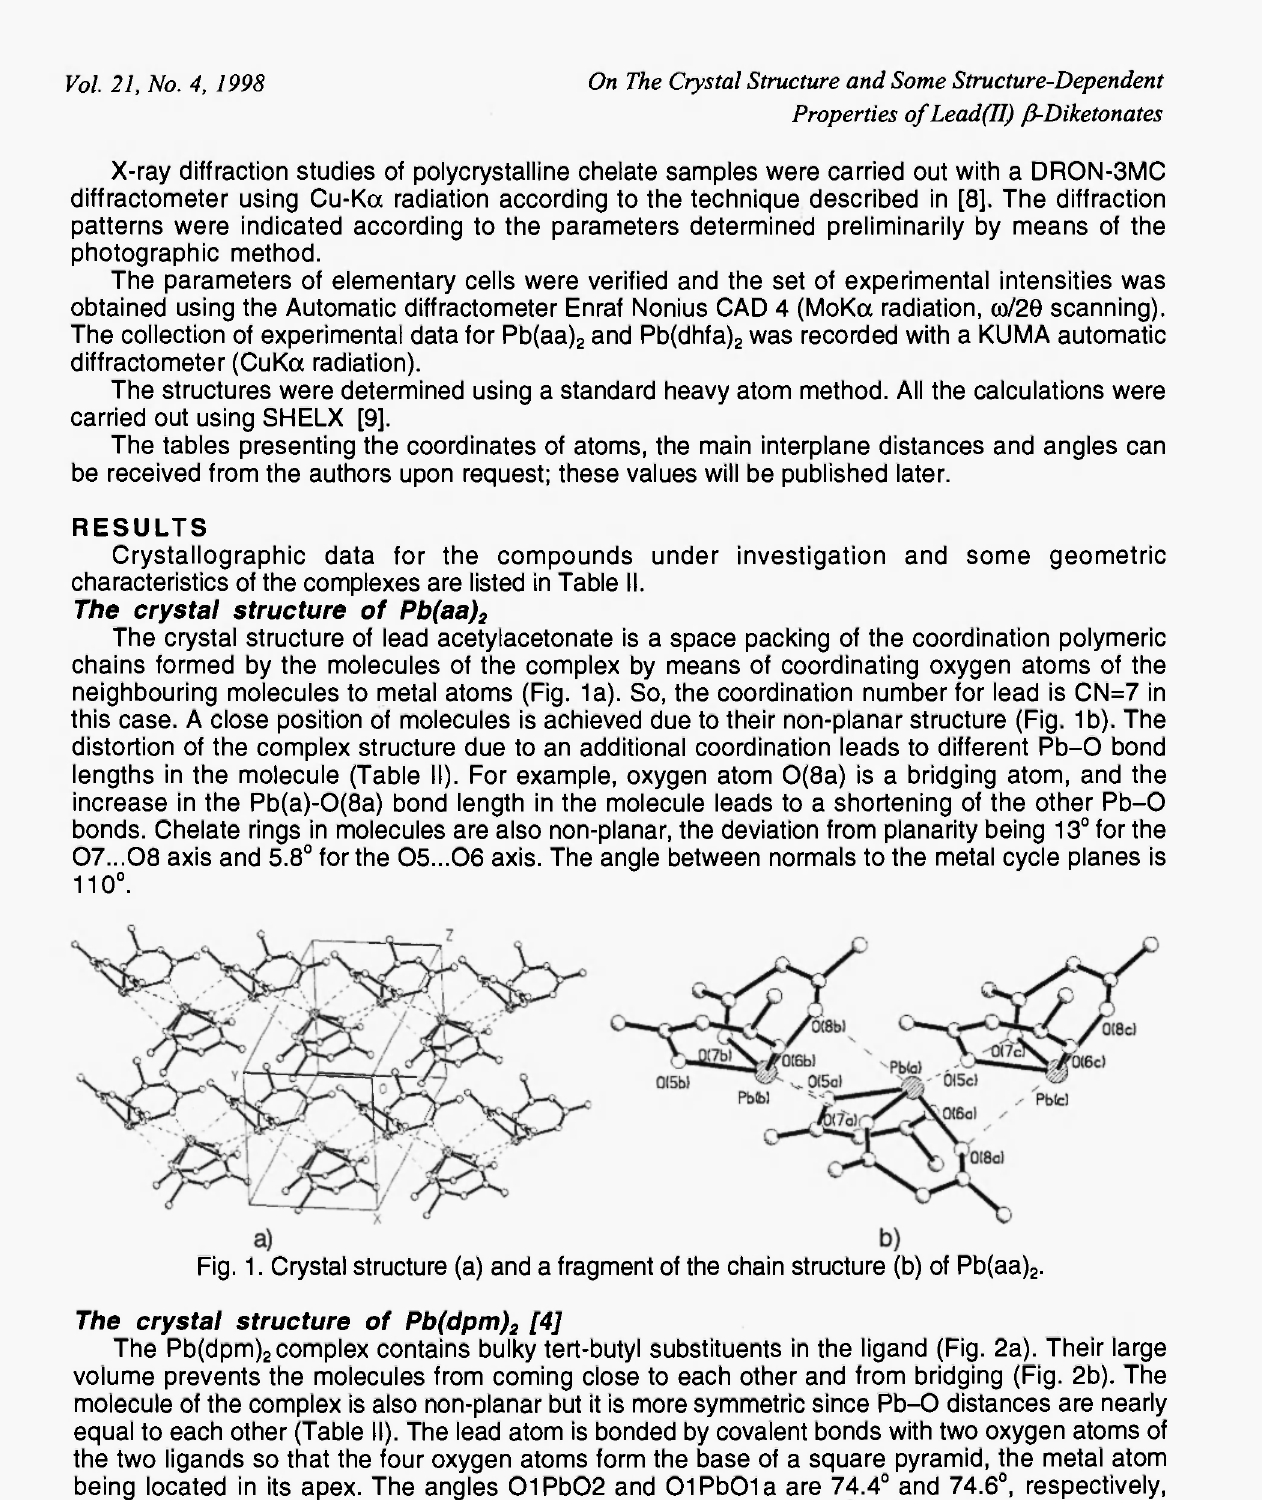
Fig. 1. Crystal structure (a) and a fragment of the chain structure (b) of Pb(aa) 2